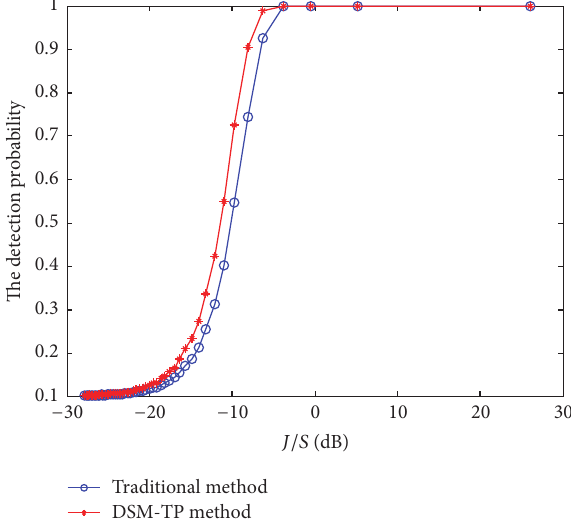
Figure 11: Detection probability for changing S/J